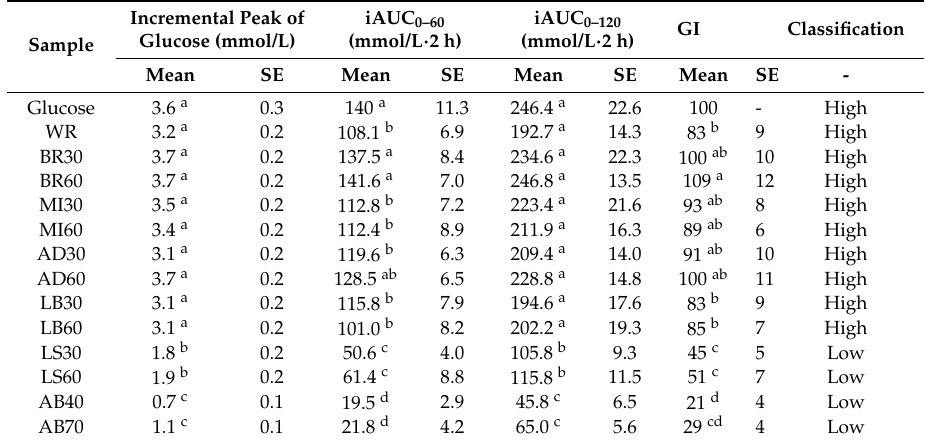
Table 3. Postprandial glycemic characteristics of test foods in 120 min (Mean values with their standard errors (SE), n =